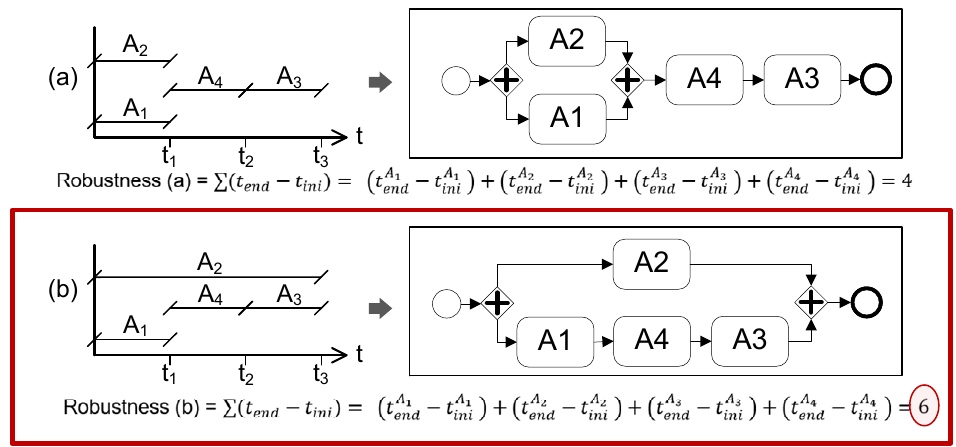
Figure 7. Flexibility of the BP in terms of the execution time of the Activities.